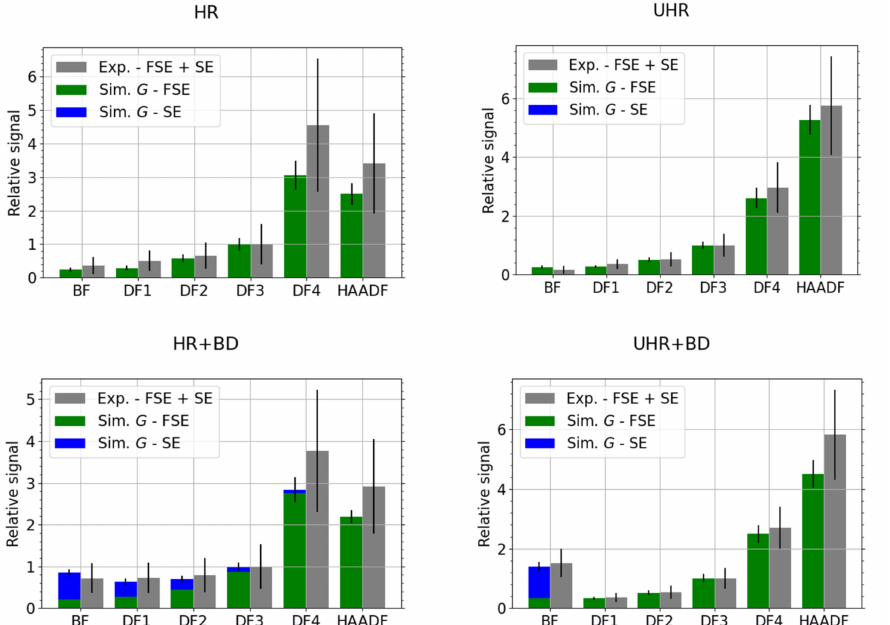
Figure 7. Mo—comparison of best-match simulated thickness 120 nm and experimental data for HR, HR + BD, UHR and UHR + BD microscope modes, E L = 15 keV. The data have been scaled to the segment